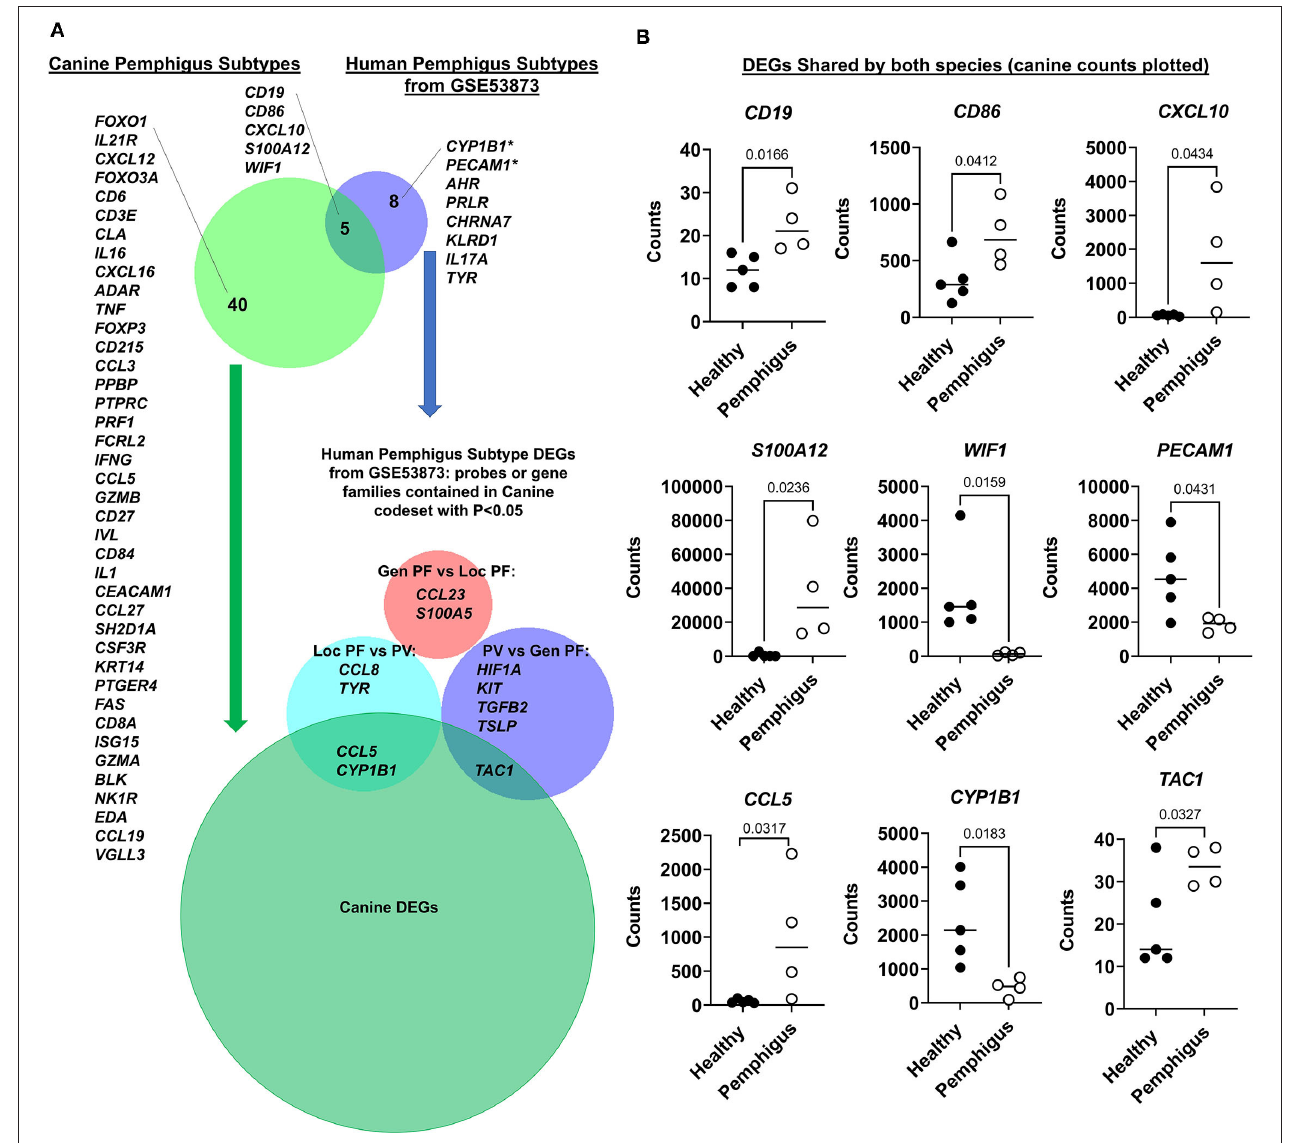
FIGURE 4 | Comparative analysis of human pemphigus cases from GSE53873 and canine pemphigus cases reveals shared DEGs. (A) Analysis of DEGs from pooled, untreated human pemphigus subtypes from GSE53873 and canine pemphigus subtypes. Further analysis of DEGs between human pemphigus subtypes as determined using GEO2R Venn Diagram function revealed that canine pemphigus captures elements of both human localized pemphigus foliaceous and pemphigus vulgaris, but not generalized pemphigus foliaceous. (B) Canine RNA counts for DEGs shared by both species are presented, including CYP1B1 and PECAM1 , which were trending toward significance in the overall canine differential expression analysis. * CYP1B1 and PECAM1 are significant when directly compared between canine pemphigus and healthy margins using two-tailed student’s t -tests (Gen PF, generalized pemphigus foliaceous; Loc PF, localized pemphigus foliaceous; PV, pemphigus vulgaris; DEGs, differentially expressed